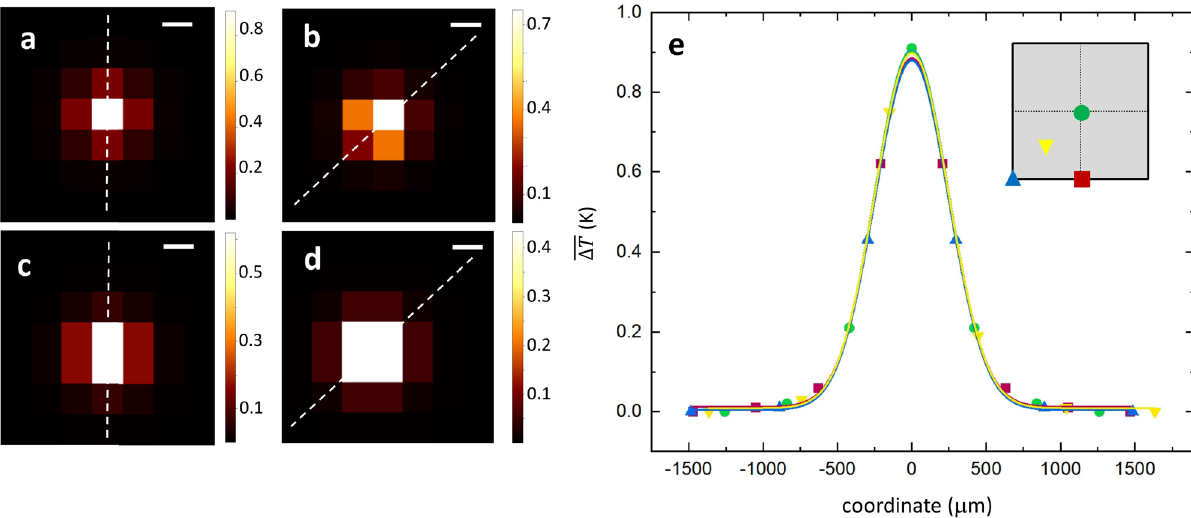
Figure 4: Camera - based detection of temperature increments. ( a ) – ( d ) Thermal - camera frame simulated by spatially averaging a PSF - convoluted ( and fourth - power elevated ) temperature distribution over a fi xed grid of adjacent pixels with 420 μm - pixel size ( ω 30 μm = , / ) ; panels ( a ) – ( d ) di ff er for the peak location of the underlying temperature distribution, which is located at the center of a camera pixel in ( a ) , halfway between the pixel center and the pixel corner in ( b ) , on top of the pixel lower edge in ( c ) , and on the lower - left pixel corner in ( d ) . The four temperature peak locations inside the camera pixel are schematically marked in green, yellow, red, and blue, respectively, in the inset of panel ( e ) . Scale bar = 420 μm for ( a ) – ( d ) ; color bars code for temperature in K. ( e ) Symbols: pixel - averaged temperature values extracted along the dashed lines in ( a ) – ( d ) ; colors code for the position of the temperature peak as de fi ned in the inset. Continuous lines: best fi ts of pixel - averaged temperature pro fi les to a Gaussian